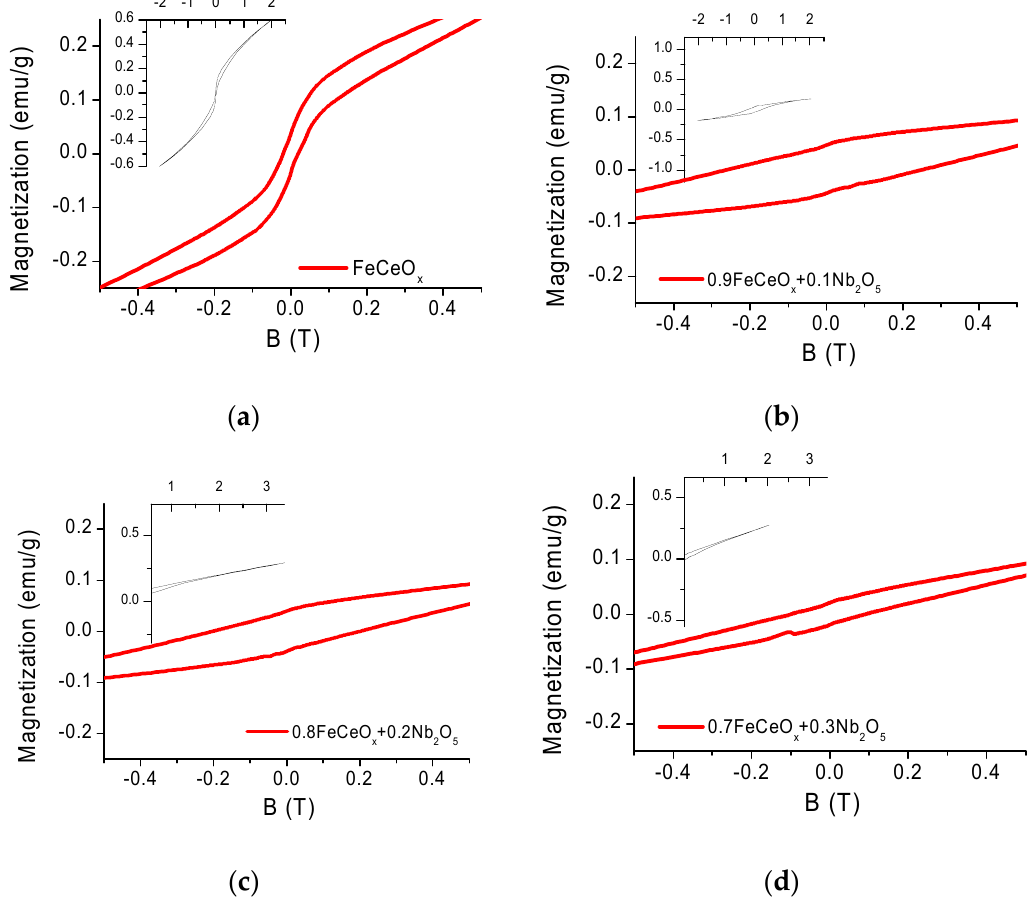
Figure 7. Hysteresis loops of the studied nanoparticles: ( a ) FeCeO x nanoparticles; ( b ) 0.9FeCeO x + 0.1Nb 2 O 5 nanoparticles; ( c ) 0.8FeCeO x + 0.2 Nb 2 O 5 nanoparticles; and ( d ) 0.7FeCeO x + 0.3 Nb 2 O 5 nanoparticles.